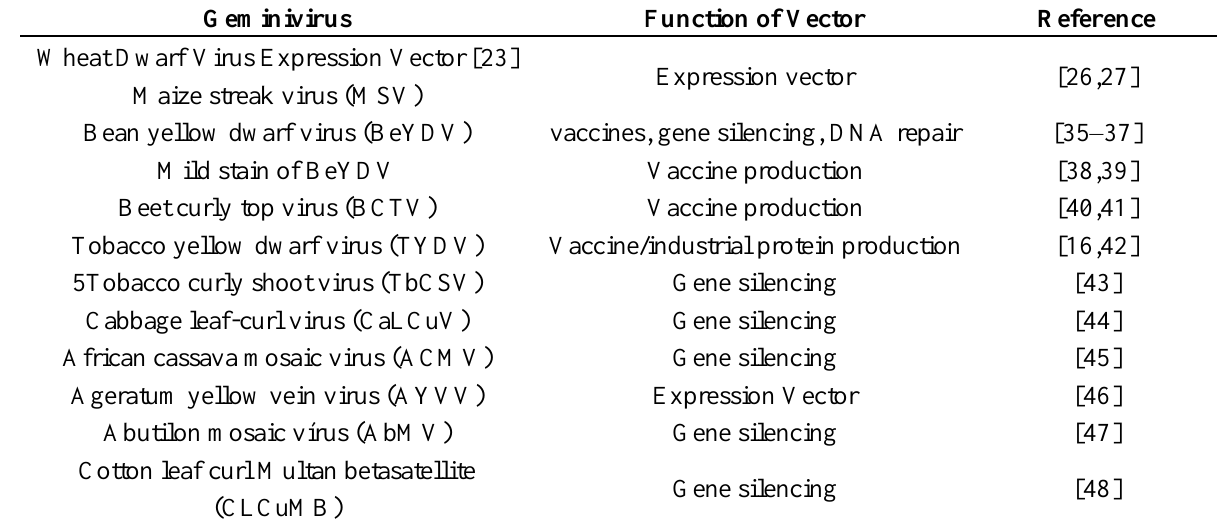
Table 1. Geminiviruses vectors listed in this